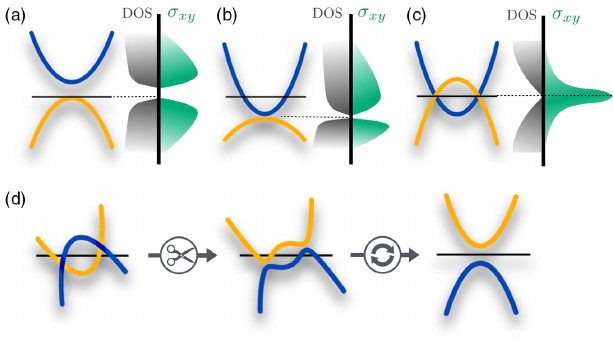
FIG. 1. Band structure, density of states, and AHC of (a) a trivial magnetic semiconductor, (b) a trivial metal, and (c) a topological metal. (d) Change in the topology of a topological metal by gapping out the crossing points via symmetry breaking or other strong perturbations. The gapped band structure is topologically equivalent to that of a trivial